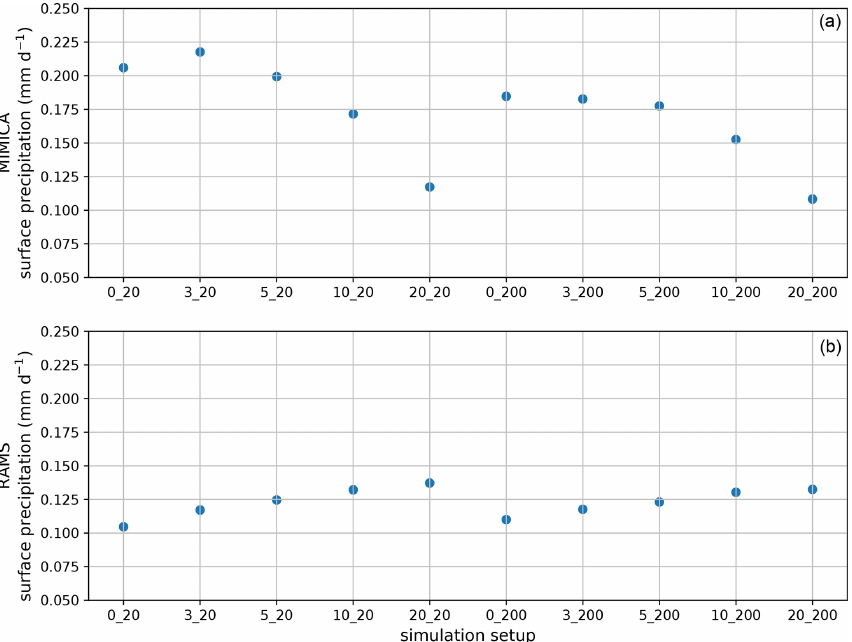
Figure A7. Time mean surface precipitation simulated by MIMICA and RAMS. For figure clarity, the plot titles have been abbreviated; the first number refers to the accumulation mode and the second to the Aitken mode concentration in cubic centimetres, i.e. 0_20 refers to